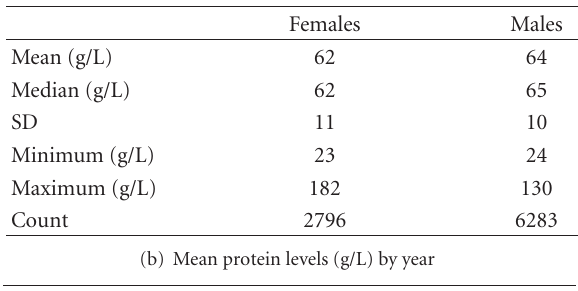
Figure 2: Prevalence of hypoviscosity in general population of patients.